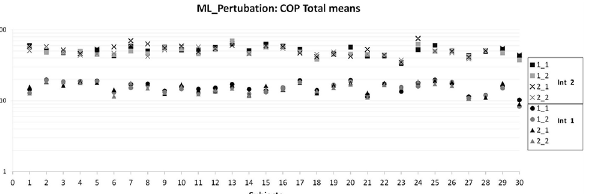
Fig 2. Mean COP Total excursions in the ML direction for all subjects, intervals and measurement sessions (1_1, ... , 2_2).